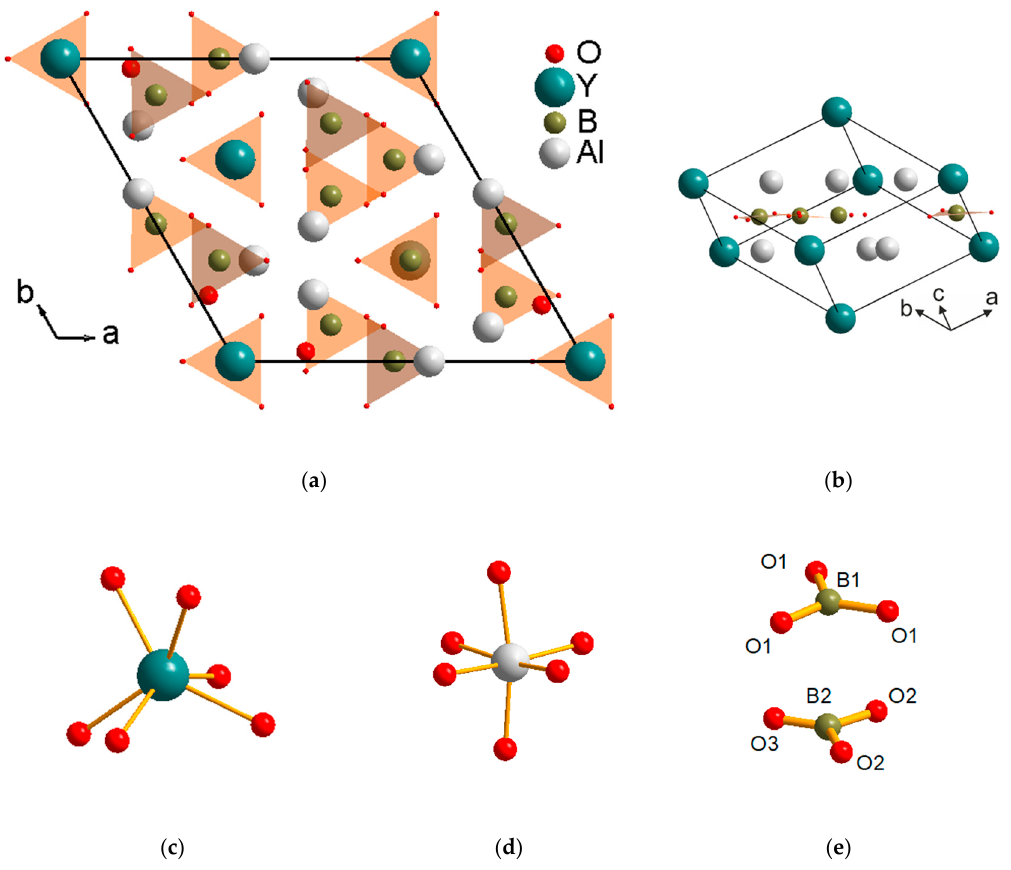
Figure 1. Projection of the YAl 3 (BO 3 ) 4 unit cell on the basal plane ( a ) and it’s primitive cell ( b ). Basic structural units: ( c ) YO 6 , ( d ) AlO 6 and ( e ) BO 3 .